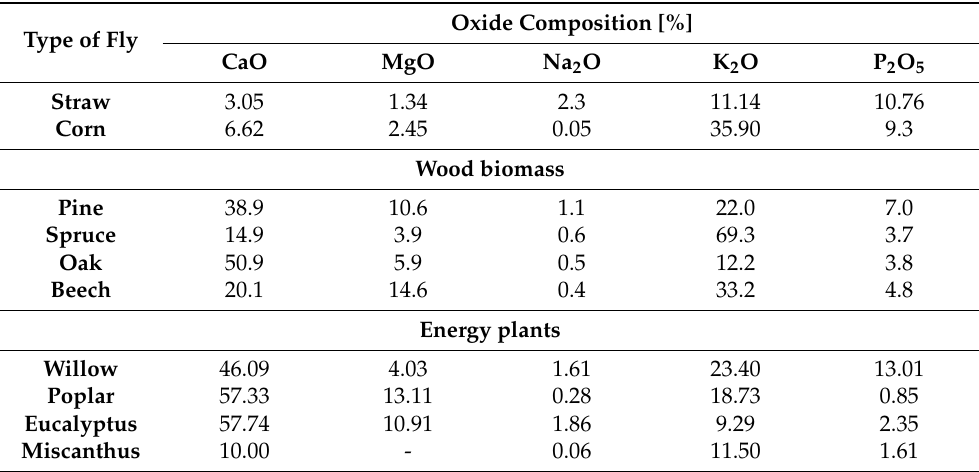
Table 1. Oxide composition of fly ashes from plants and wood biomass as well as energy plants combustion.